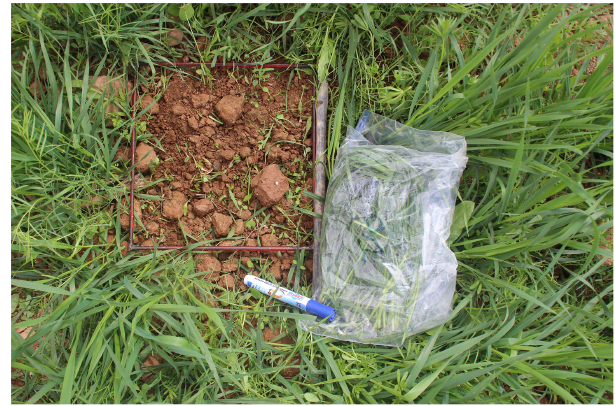
Figure 5. Photo taken during a measurement campaign illustrating a sample of aboveground biomass